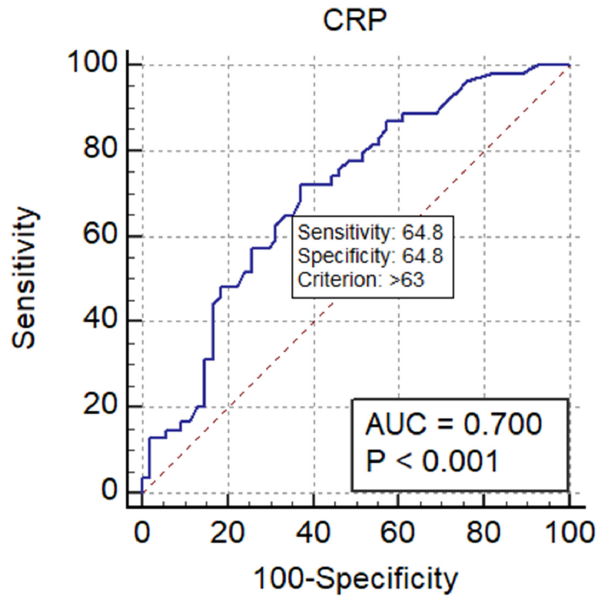
Figure 3. Corresponding point of cut-off values of CRP on the ROC curve (AUC) (Se = Sp).